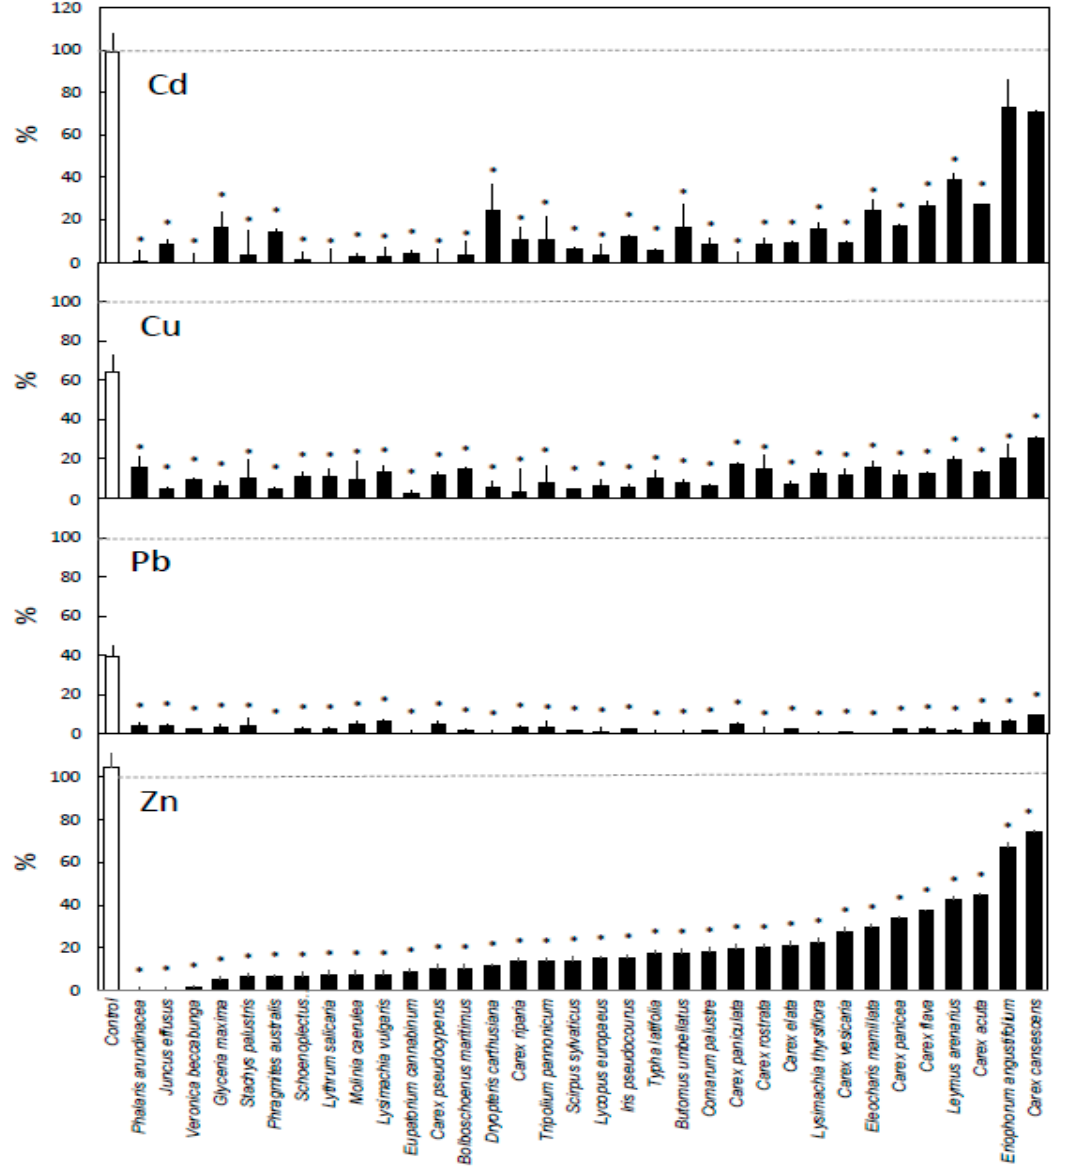
Figure 2. Remaining metal in solution after 5 days of exposure. Pairwise comparisons made within each metal between no-plant control (white bar) and every species (black bars), where * = p < 0.05. Dotted line represents initial concentration (at 0 h = 100%). n = 3, ± SE for all plants, n = 21, ± SE, for no-plant control.